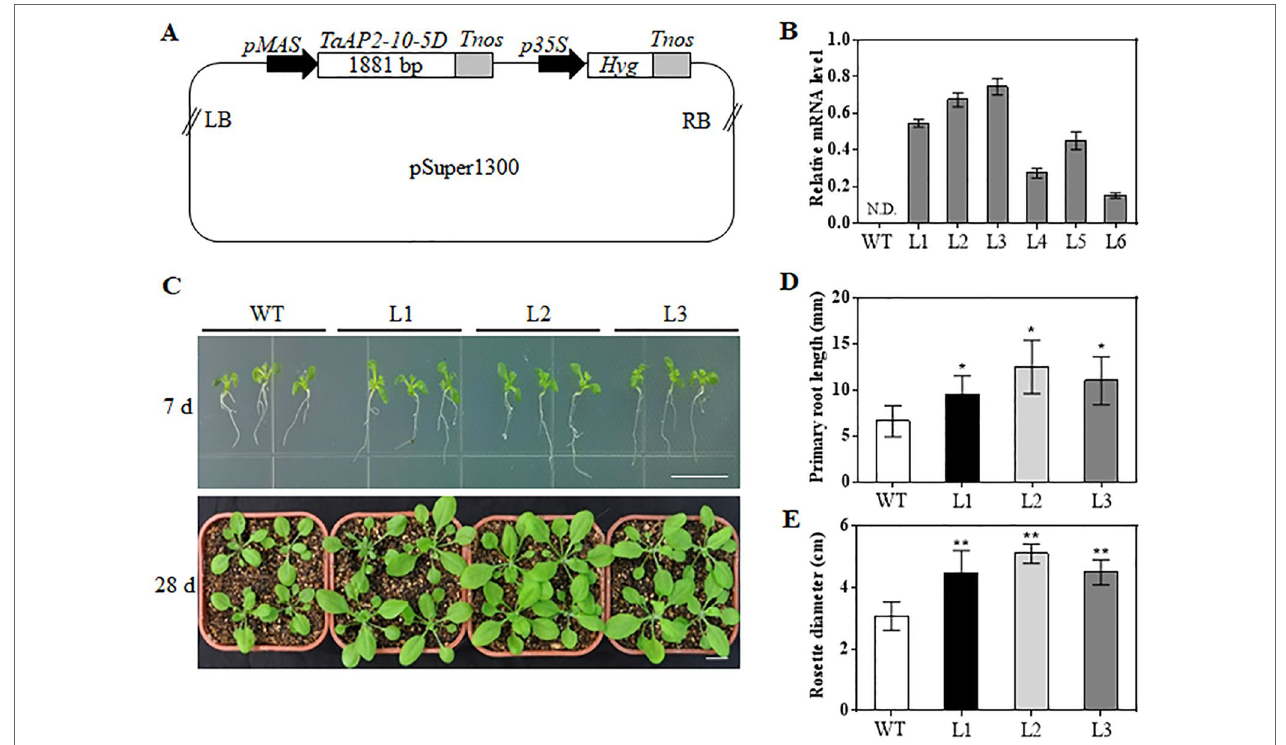
FIGURE 6 | Morphological differences between WT and TaAP2-10-5D transgenic plants at seedling stages. (A) Schematic diagram of the construct containing the TaAP2-10-5D expression cassette. LB, left border; pMAS , mannopine synthase promoter; Tnos , nopaline synthase gene ( NOS ) terminator; p35S , cauliflower mosaic virus 35S promoter; Hyg , Hygromycin-resistance gene ; RB, right border. (B) Transcript levels of TaAP2-10-5D in T 3 transgenic Arabidopsis lines revealed by qPCR analysis. Bars indicate standard deviations of three biological replicates. N.D., Not Detected. (C) Phenotype of WT and TaAP2-10-5D transgenic seedlings grown for 7 and 28 days. (D) Root lengths of the WT and TaAP2-10-5D transgenic plants at the 7 day after sowing. (E) Rosette diameters of 28-day-old WT and TaAP2-10-5D transgenic plants. Bars = 10 mm. Mean values were calculated from 10–20 biological replicates, with error bars representing standard deviations. Statistically significant differences are indicated: *, P < 0.05; **, P < 0.01 (Student’s t